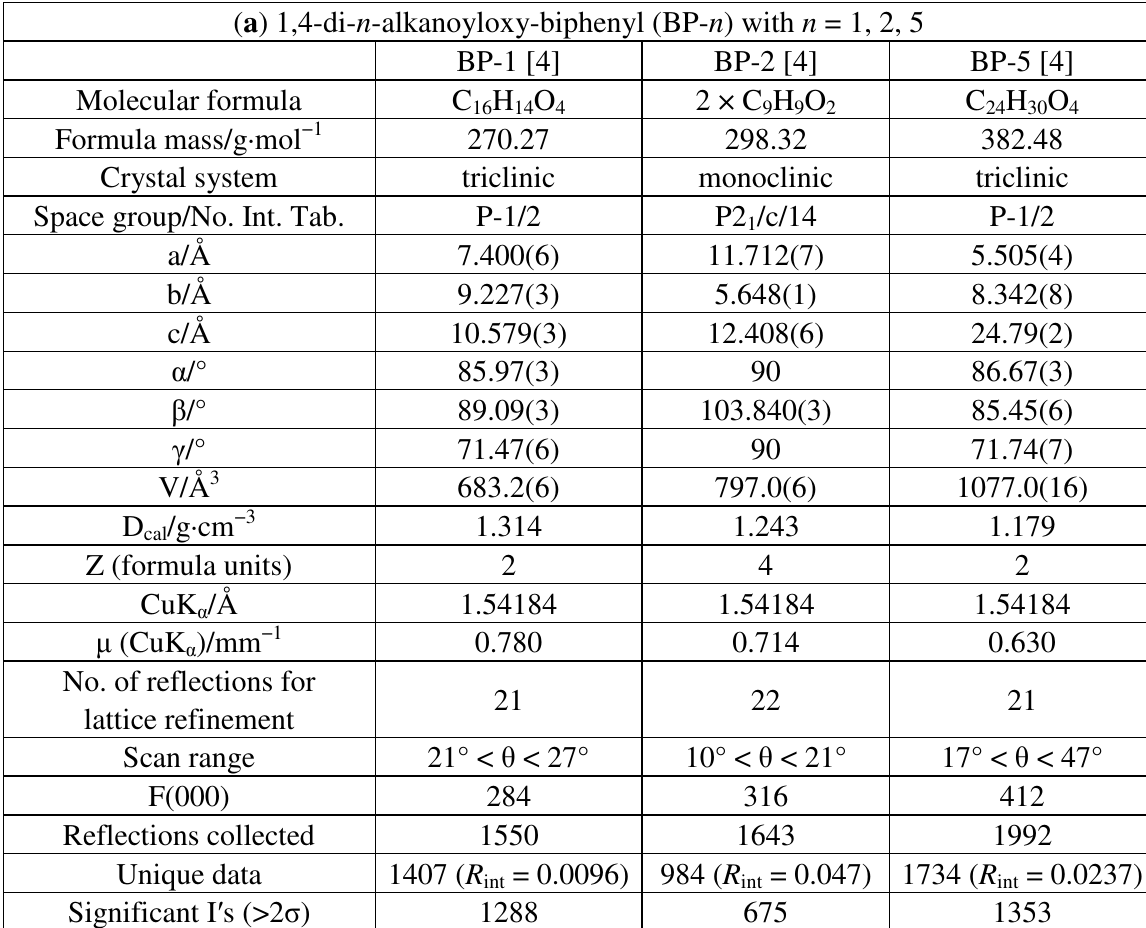
Table 6. Summary of crystallographic data of BP- n collected at ambient